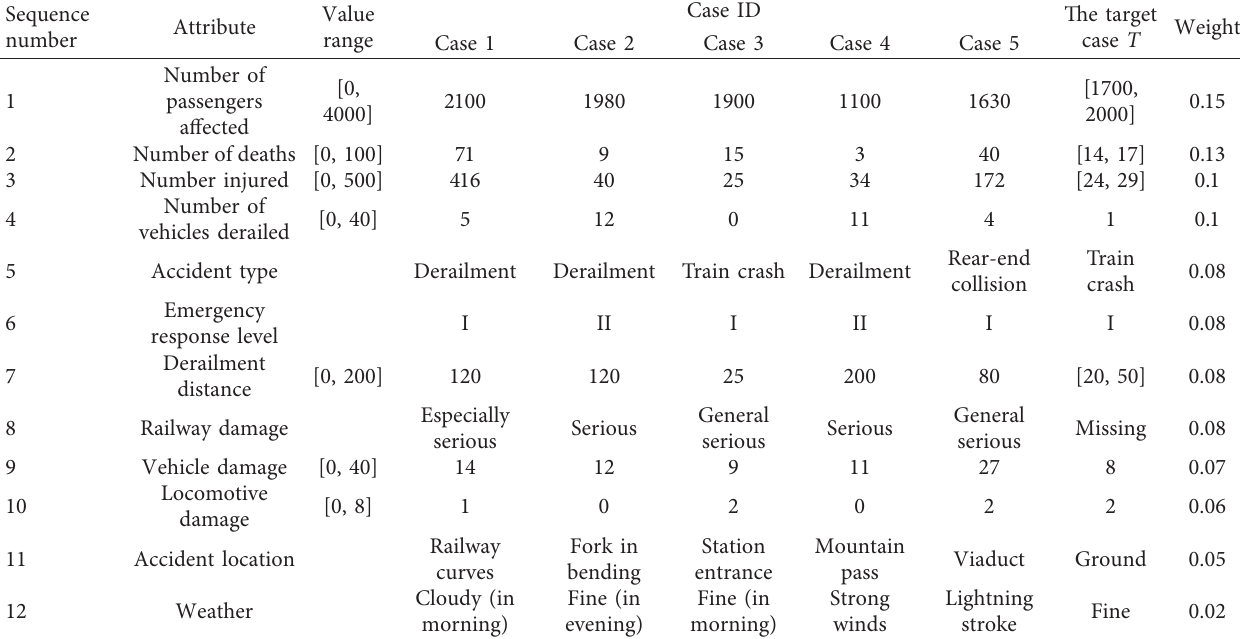
Table 2: The weight values of